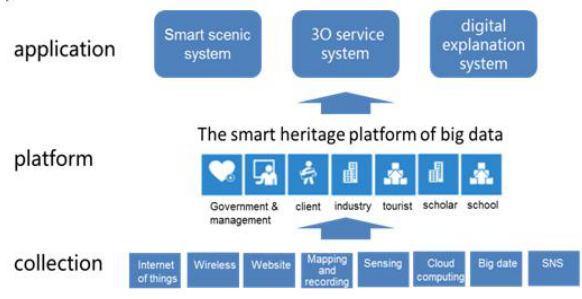
Figure 4: One platform-three systems